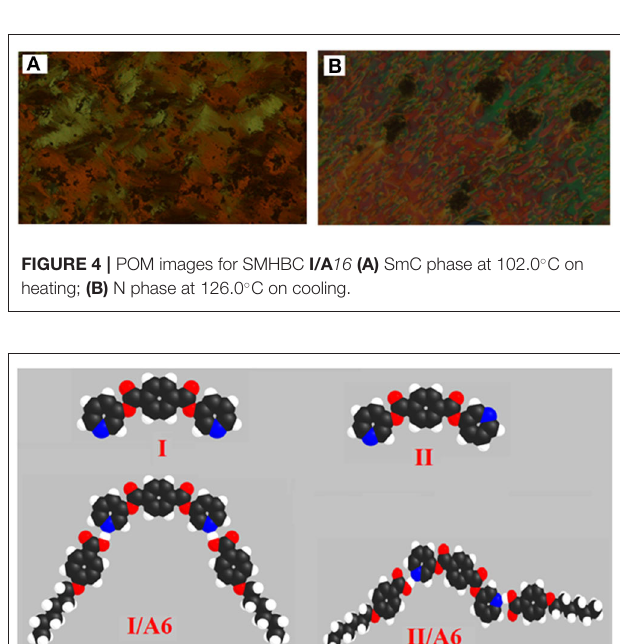
Table 1 . Results indicate that the variation in the entropy changes when the terminal flexible-chain length varies in an irregular manner. This may be attributed to differences in the molecular interactions between individual molecules. These were found to be the differences in polarizability, dipole moment, aspect ratio, and their geometrical structures (Lizu et al., 2010).